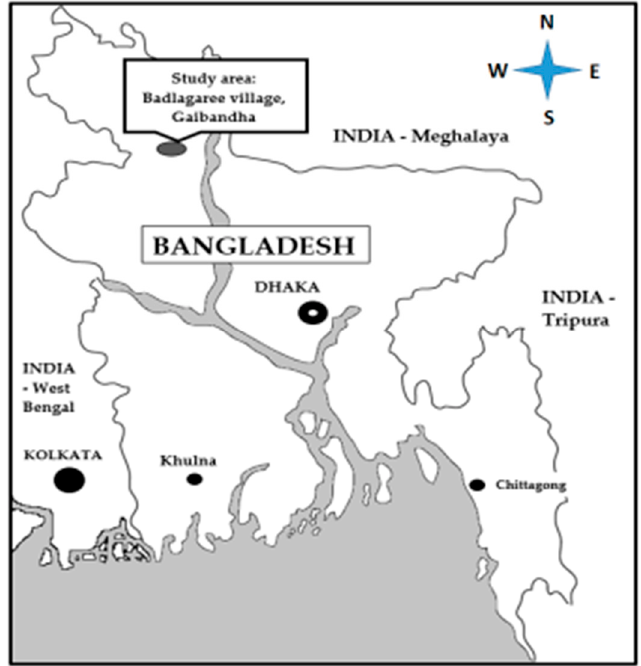
Figure 1. The fieldwork location at Badlagaree in Bangladesh.